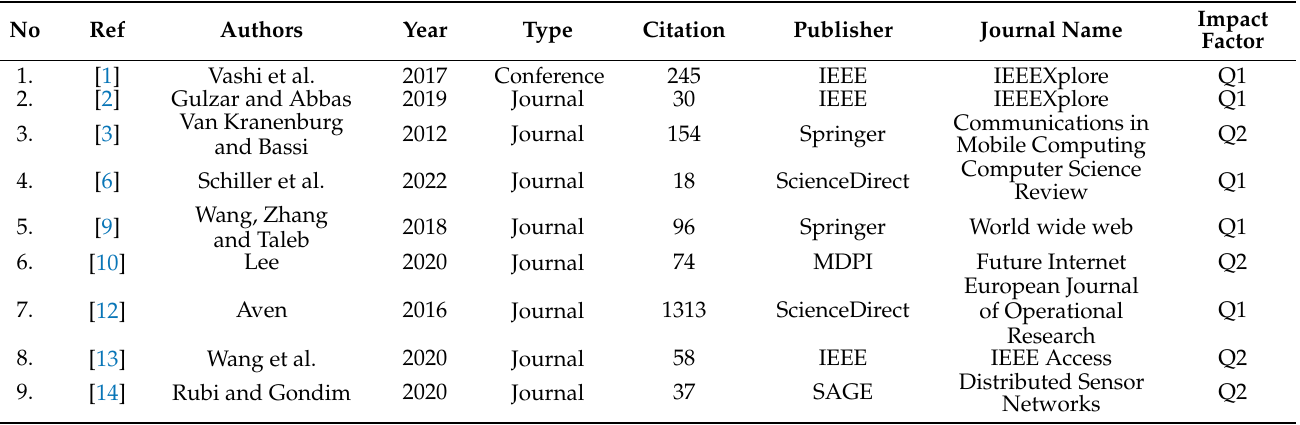
Table 4. Statistical analysis of the papers